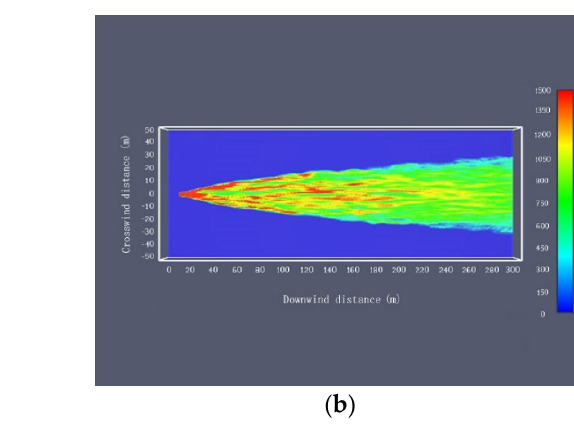
Figure 6. Distribution map of the diffusion concentration in the Z plane (H = 2 m) when the atmos- pheric environment is stable at t = 60 and 120 s (top view).